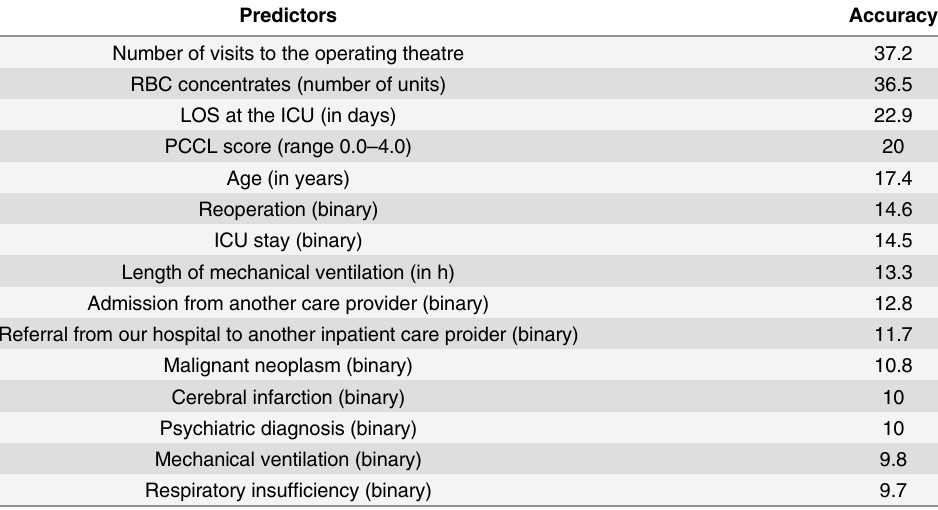
Table 3. 15 most important predictors for deficit outliers defined by the IQR method derived from Ran- dom forest analysis. Predictors were ordered by their accuracy (n = 20,000, training set) Predictors